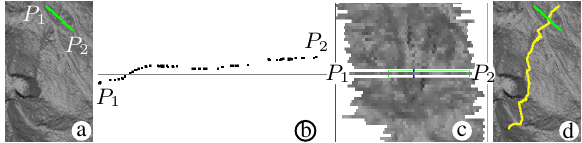
Figure 2. Extraction framework; a) input stroke P 1 P 2 ; b) first